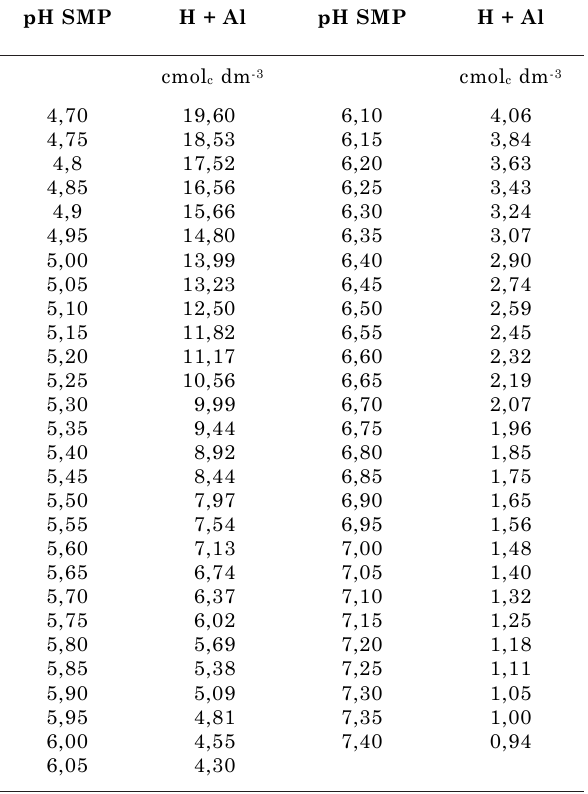
Quadro 2. Estimativa da acidez potencial a partir do pH SMP para solos da Região Vale do